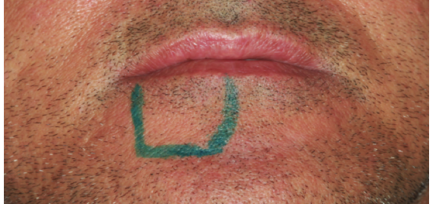
Figure 34: Demarcation of sensory change area in the 28-day postoperative